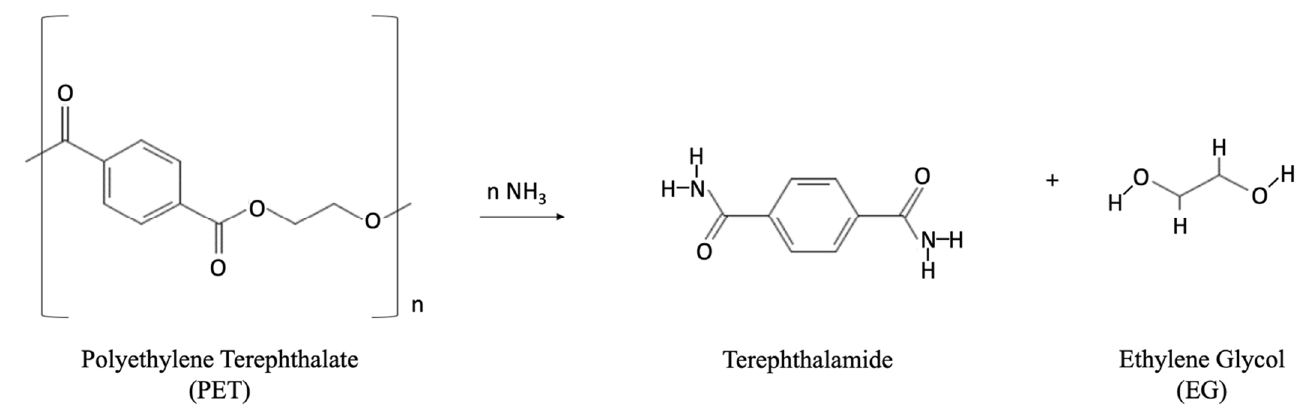
Figure 9. Chemical reaction during ammonolysis process to produce terepthalamide.